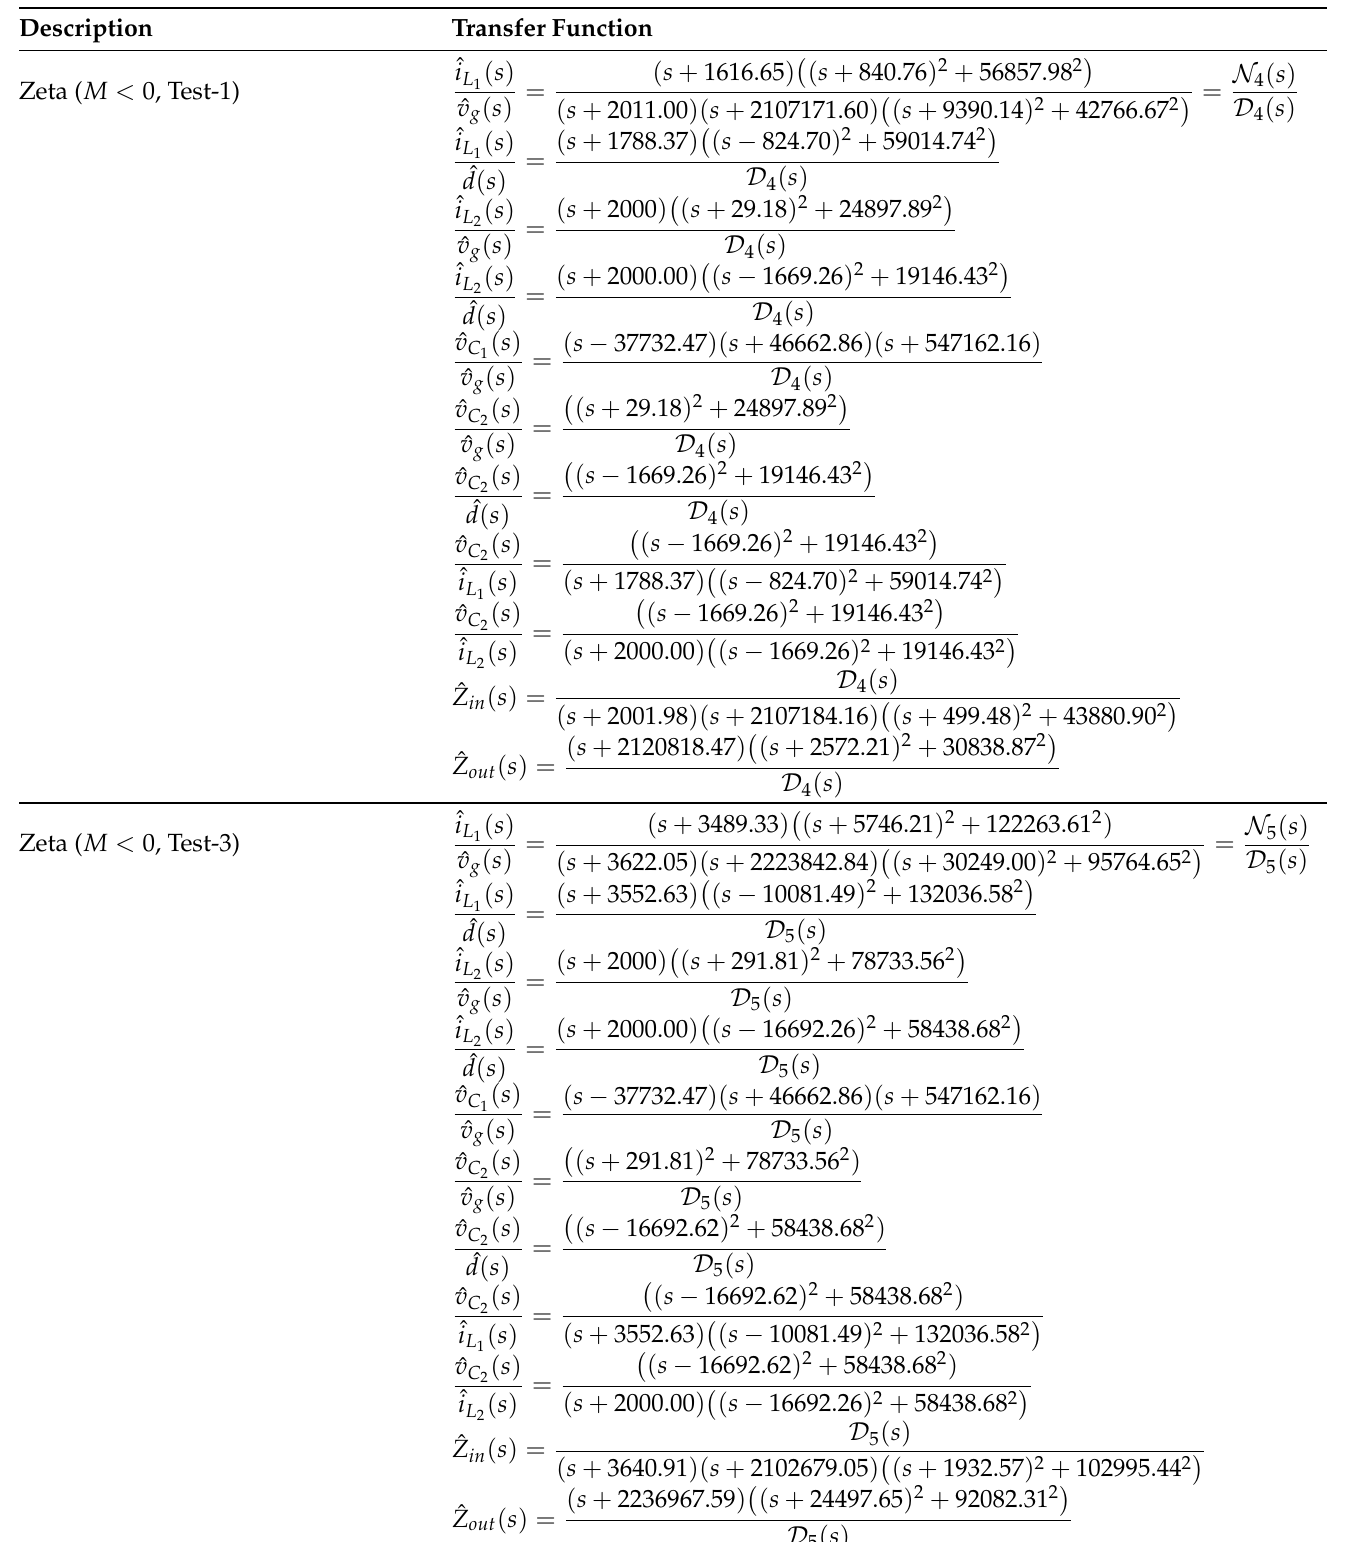
Table 7. Theoretical transfer functions of the Zeta converter under the tests conditions depicted in Table